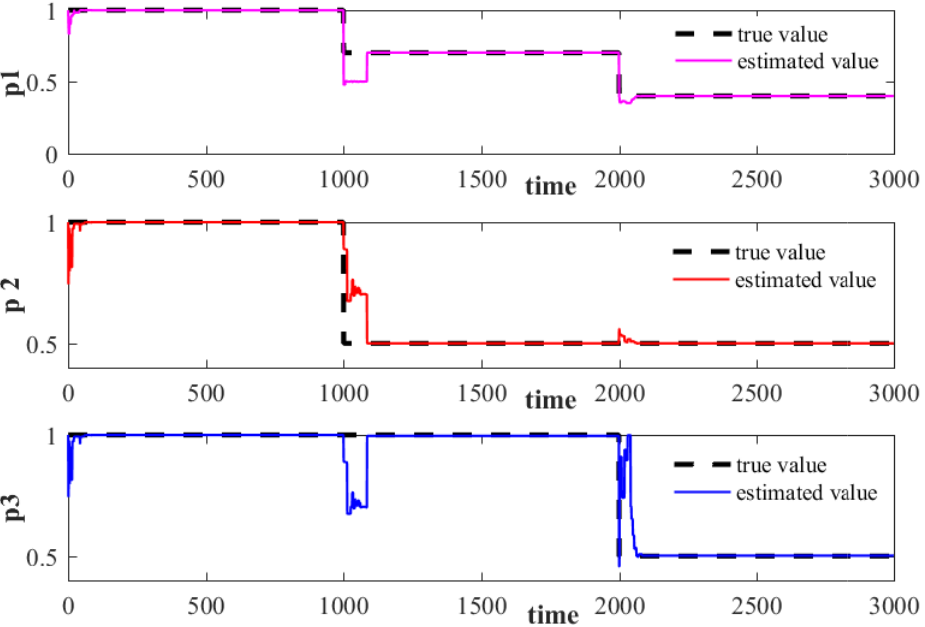
Figure 4. Euclide distance based parameters estimation (noise free).